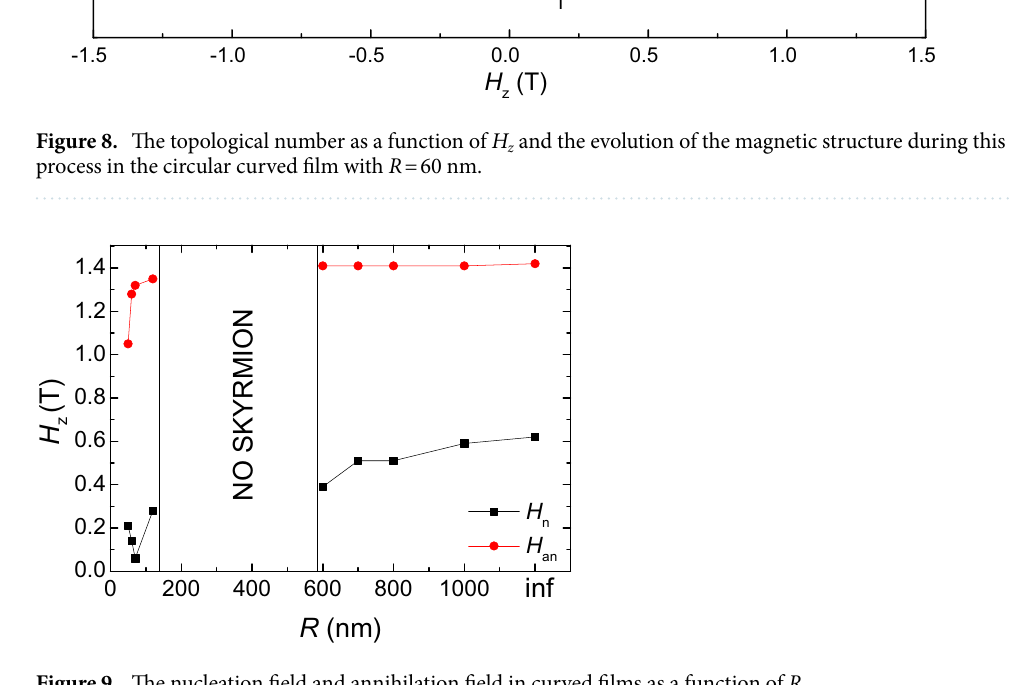
Figure 9. The nucleation field and annihilation field in curved films as a function of R